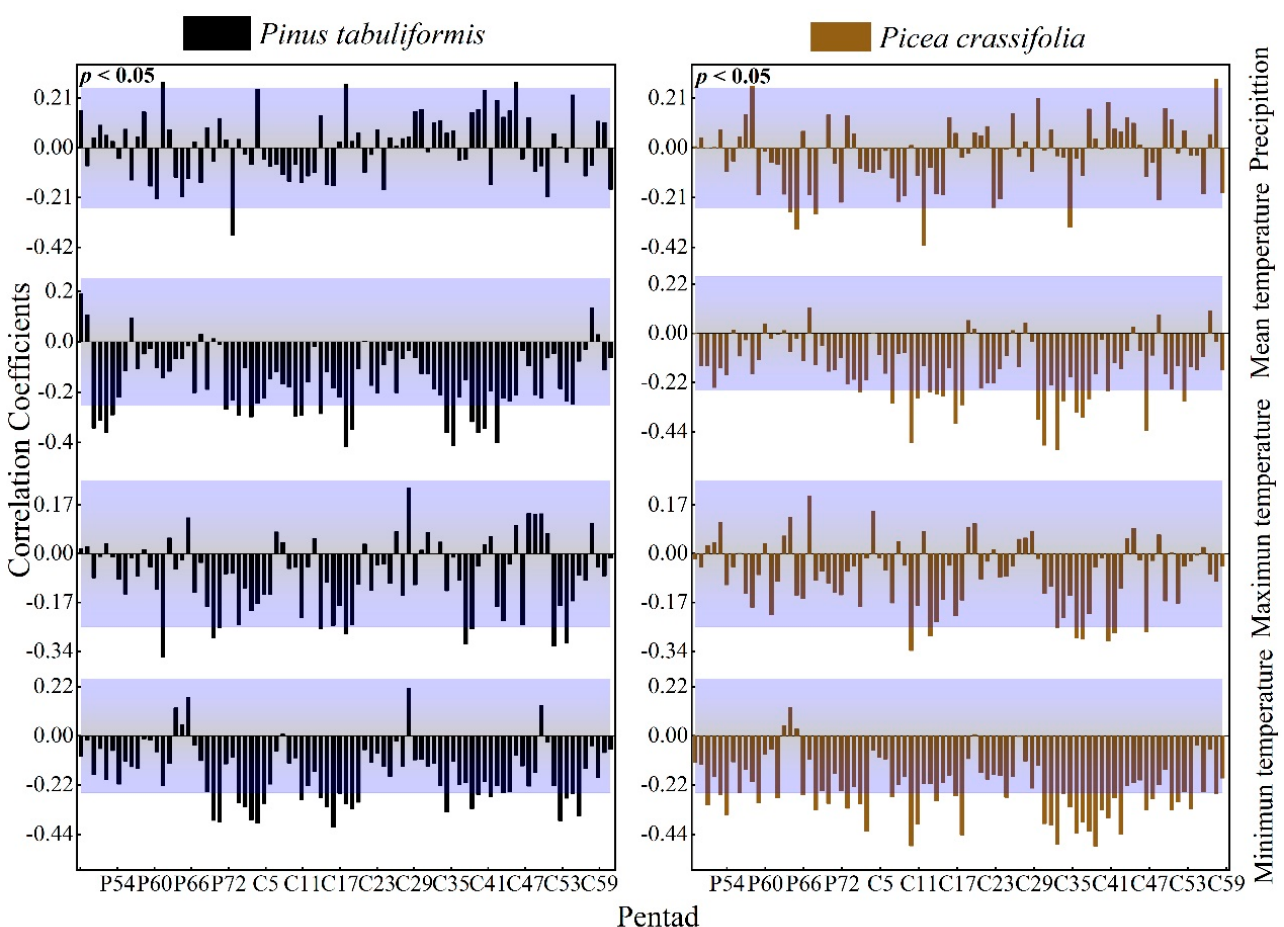
Figure 6. Response of the radial growth of trees to pentad values of climatic factors (Beyond the top of the purple shade, p values are positively correlated ( p < 0.05), lower than the part in purple shadow indicates that p values are negatively correlated ( p < 0.05).